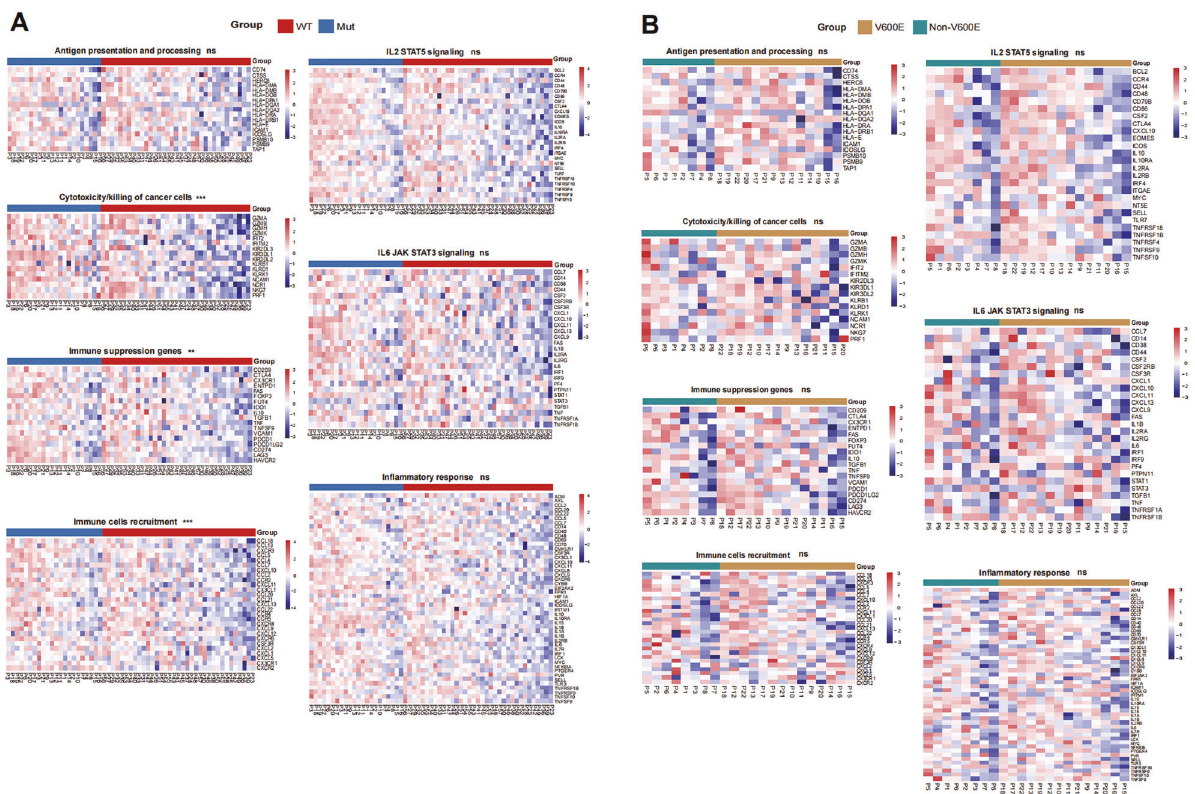
Fig. 3 The effect of BRAF mutation on different immune-related signaling pathway in NSCLC. A Headmap analysis of gene transcripts involved in various immune pathways in the WT and BRAF mutated NSCLC specimens. B Heatmap analysis of genes transcripts involved in various immune pathways in the BRAF V600E and Non-V600E NSCLC